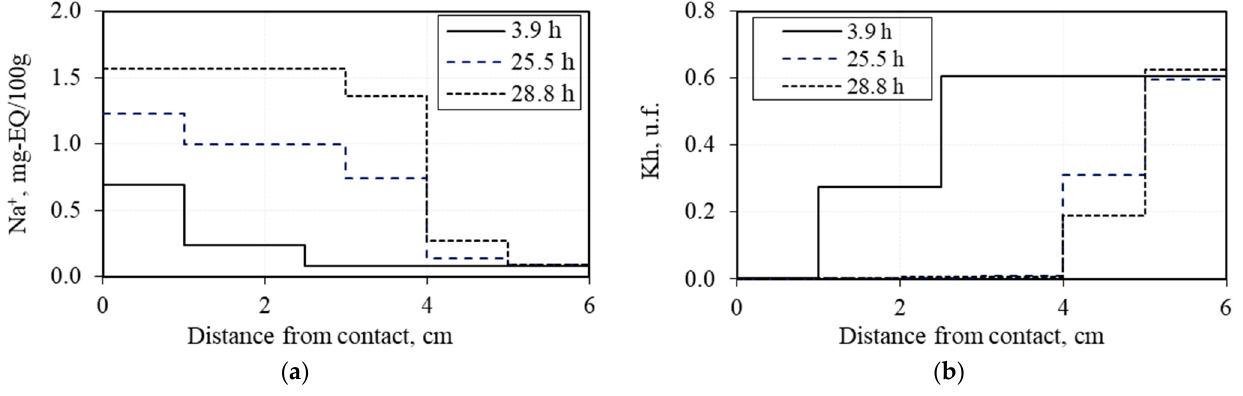
Figure 2. Changes of Na + contents ( a ) and hydrate coefficient ( b ) in frozen hydrate-bearing sand ( K hin = 0.6, W = 12%) for 3.9, 25.5, and 28.8 h of interaction with a 0.1 N NaCl solution at 0.1 MPa and − 6 °C .